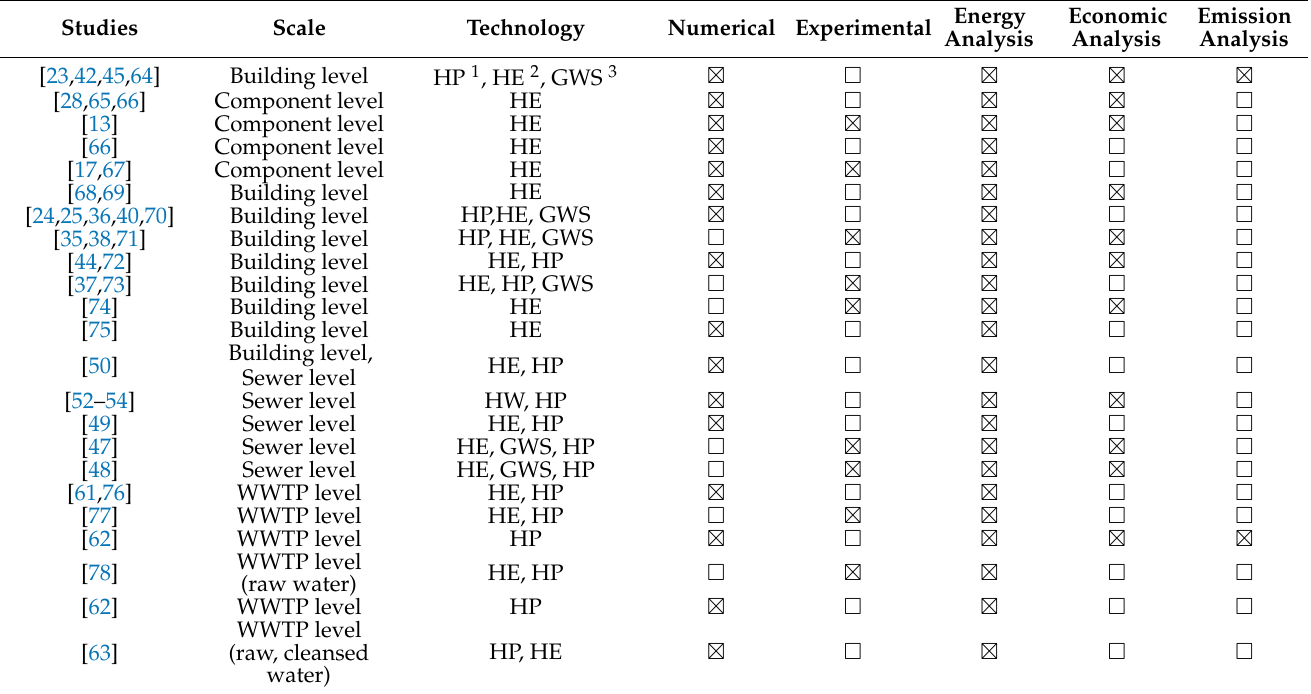
Table 1. Summary of studies analyzed in the present research. Studies Scale